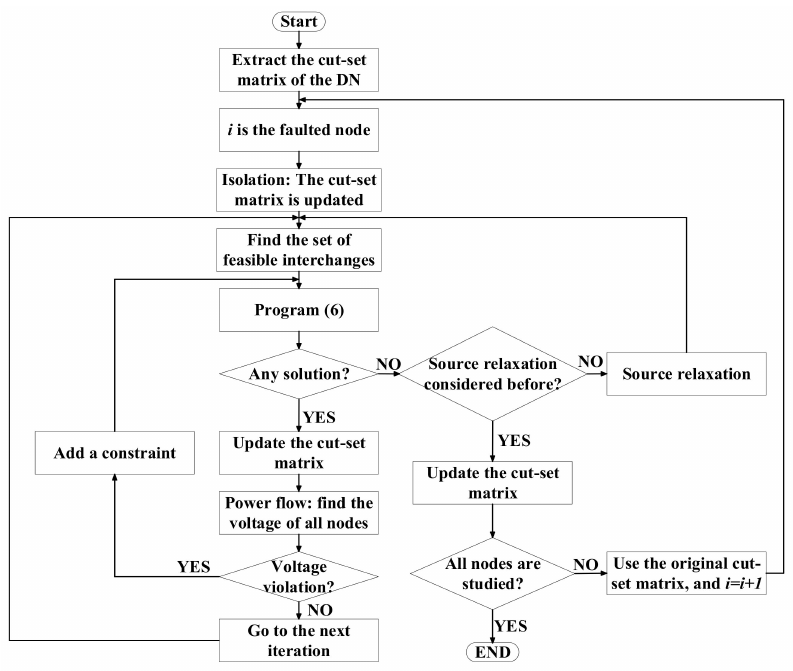
Figure 3. The flowchart of the first level of proposed